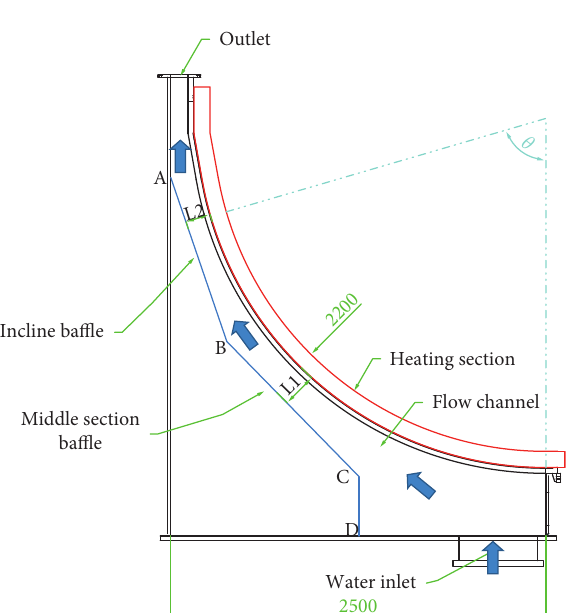
Figure 5: Schematic of the test